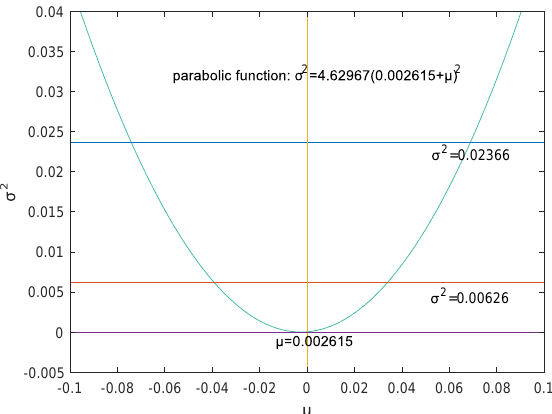
Figure 4. The joint confidence region of ( µ , σ 2 ) by area minimization